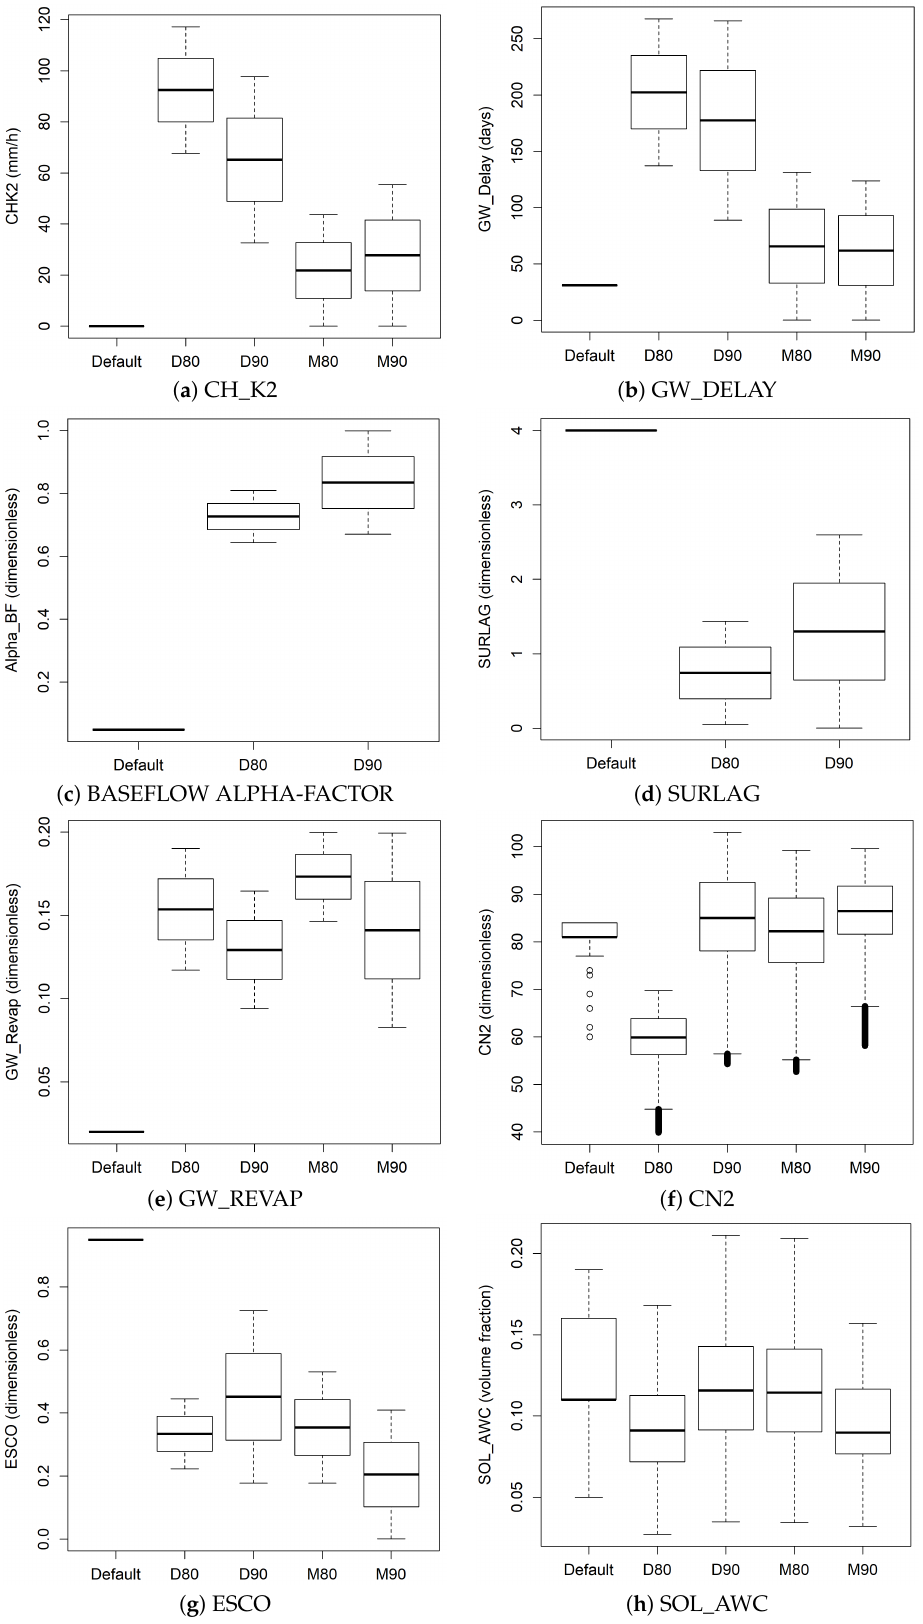
Figure 2. Calibrated parameter set of basin lumped parameters. Boxplots show parameter ranges. ( a ) CH_K2 and ( b ) GW_DELAY had differences across calibration time-steps; ( c – f ) ALPHA_BF, SURLAG, GW_REVAP, and CN2 showed (variable extent) decadal changes; and ( g ) ESCO and ( h ) SOL_AWC did not show any discernible